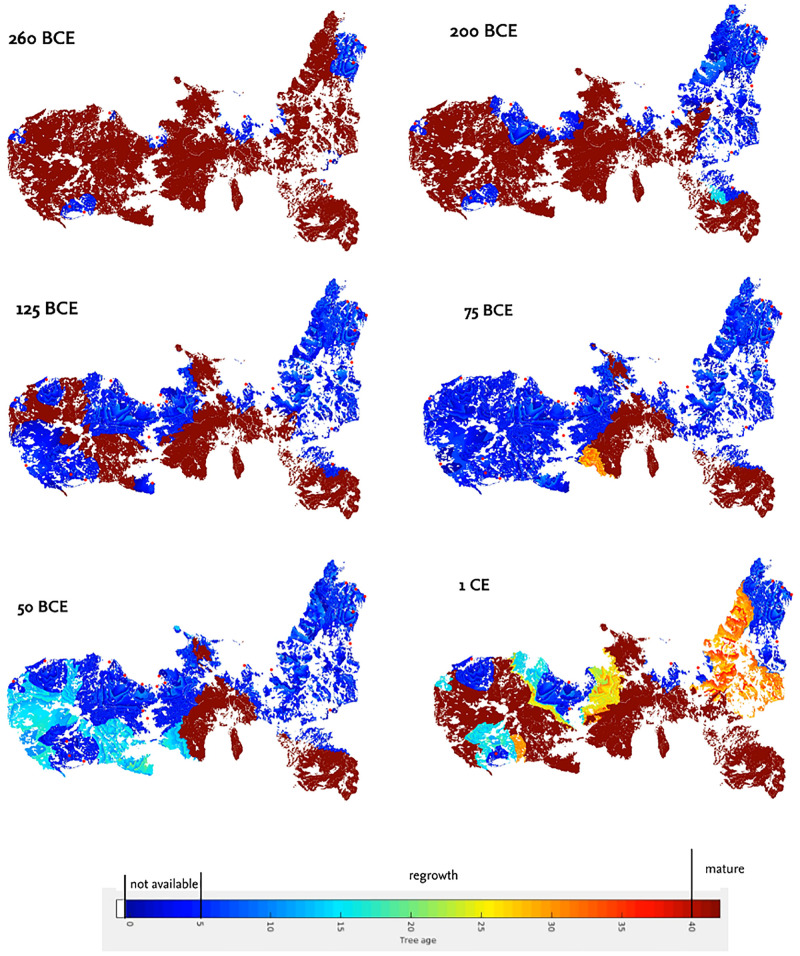
The modelled distribution of woodlot area on Elba in different time slices.Data is from a simulation using the mean values of the parameter distributions as input. Dark blue indicates that trees in the area were not available for harvesting (< 5 yrs)), light blue to orange indicates that the trees in the area are regrowing. Mature trees (> 40 yrs) are indicated in reddish brown.